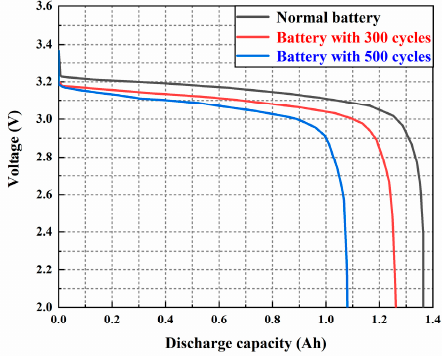
Figure 8. Discharge curve of the battery under three cycle times [23].